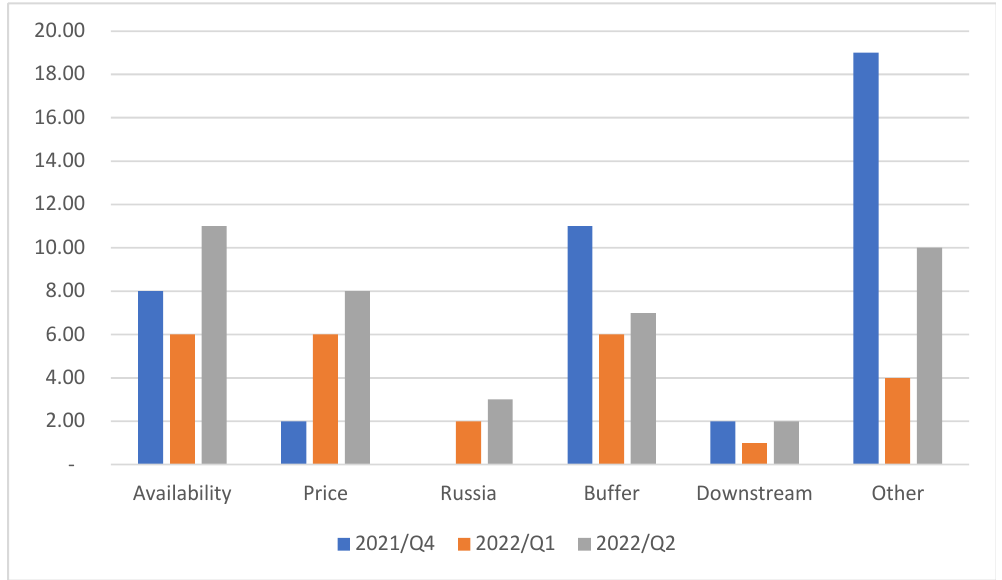
Figure 5. Reasons for increasing inventory investment among publicly traded companies.